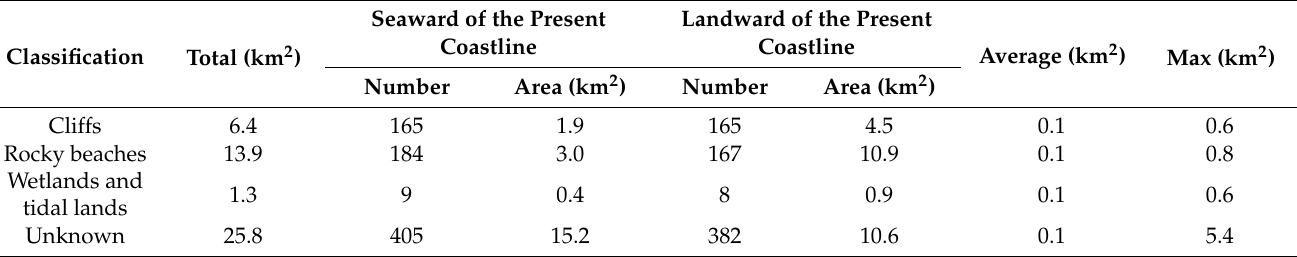
Table 3. Number of gaps and their areas in the non-surveyed (estimated) coastlines in Japan (the section of sea-based measurement).